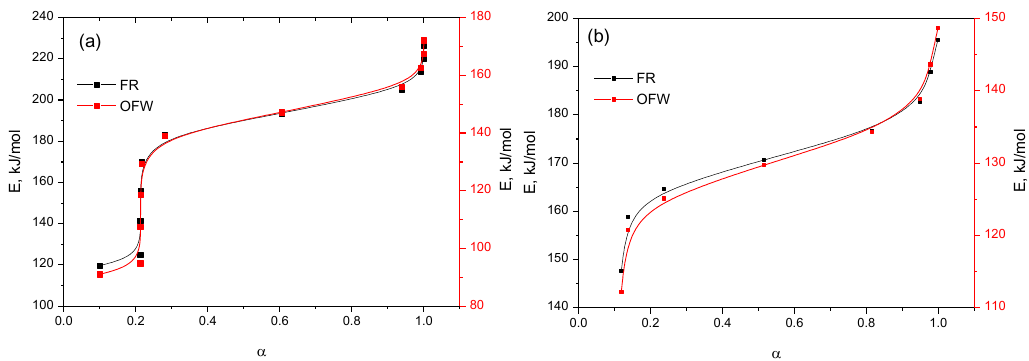
Figure 12. Dependences of activation energy (Ea) on the degree of transformation (α) for ( a ) β -CD – resveratrol (2:1) and ( b ) β -CD – resveratrol (4:1).